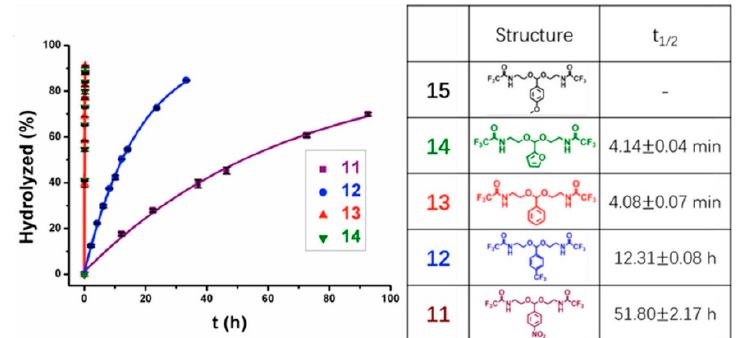
Figure 12. Substituent effects upon the hydrolysis of benzylidene acetals. Electron-withdrawing substituents significantly contributed to decreased hydrolysis rate of acetals. As compared to phenyl substituent with half-life of 4 min, trifluoromethyl increased the half-life of acetal to around 12.3 h. The presence of a resonance-based electron-withdrawing functionality further increased the half-life to 51.8 h. Reproduced with permission from Bin Liu and S. Thayumanavan, Journal of the American Chemical Society; published by American Chemical Society,